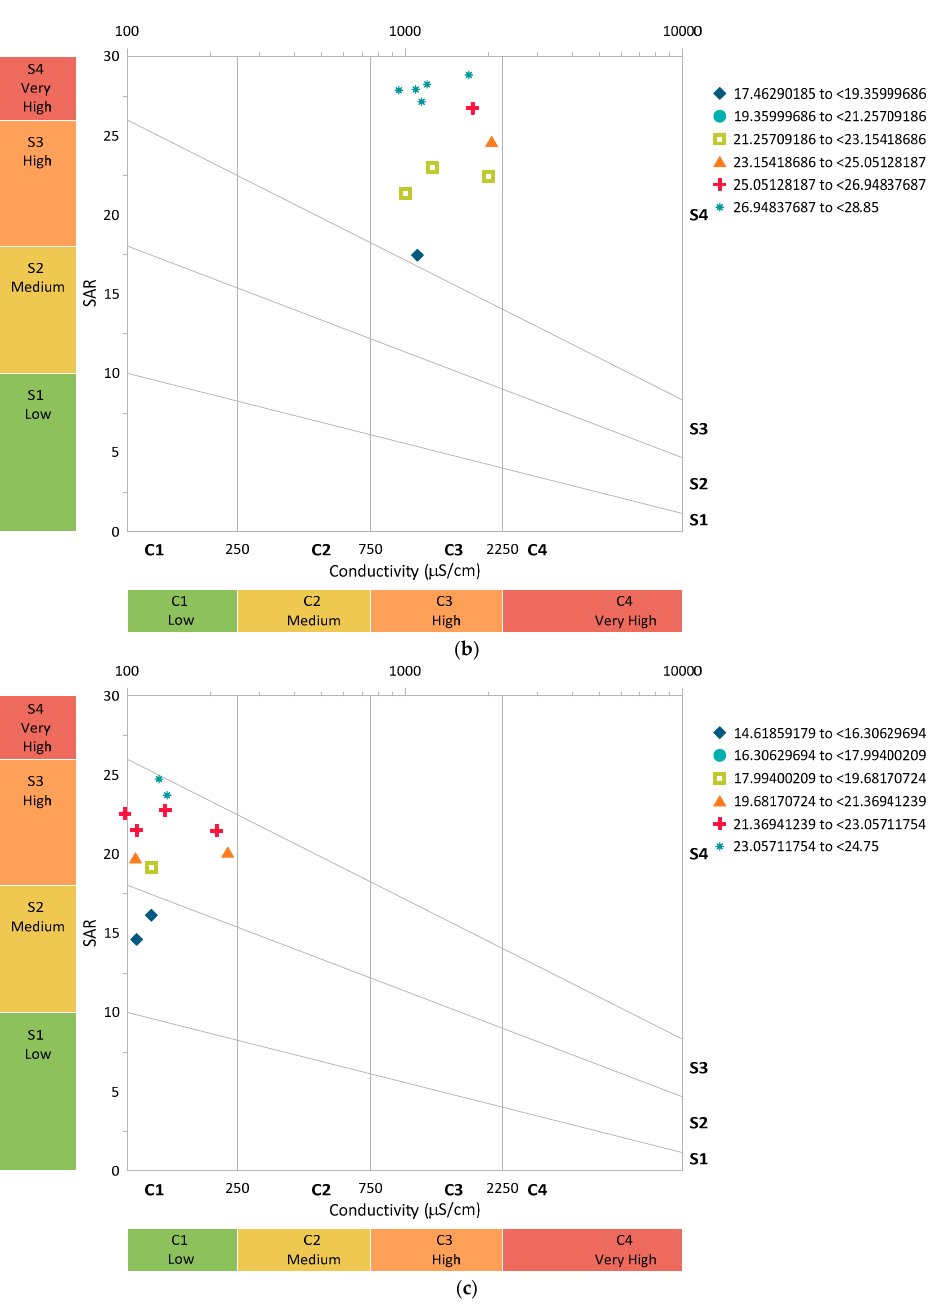
Figure 5. The salinity hazard potential from different water sources: ( a ) raw groundwater; ( b ) 0.5 m column depth; ( c ) 1 m column depth (V f : 0.0035 L/s; pH: 6.4–12.5; T: 22.6–24.4 °C; n = 8).